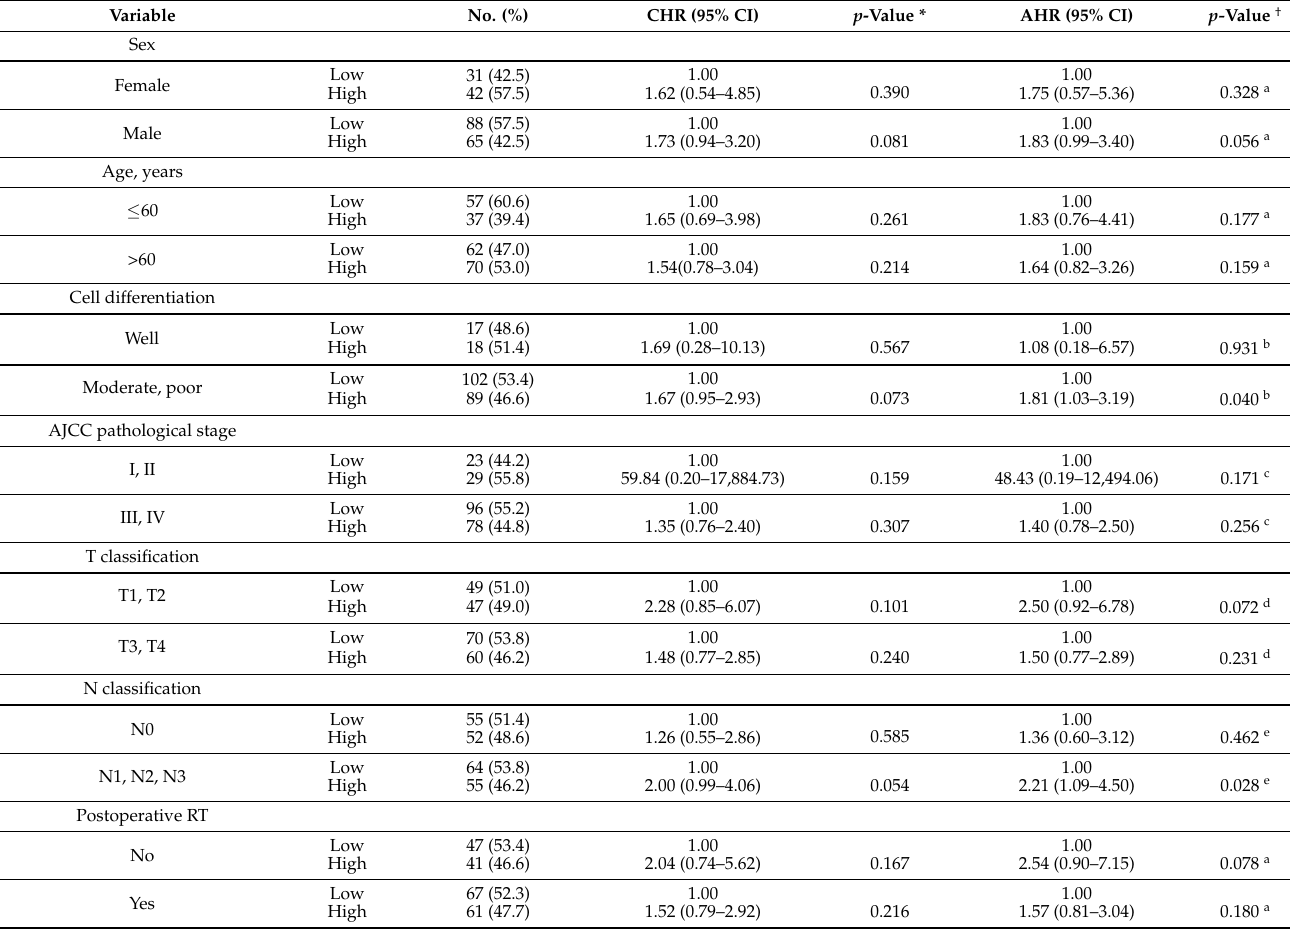
Table 3. The GBP5 gene expression in disease-free survival of oral cancer patients from TCGA